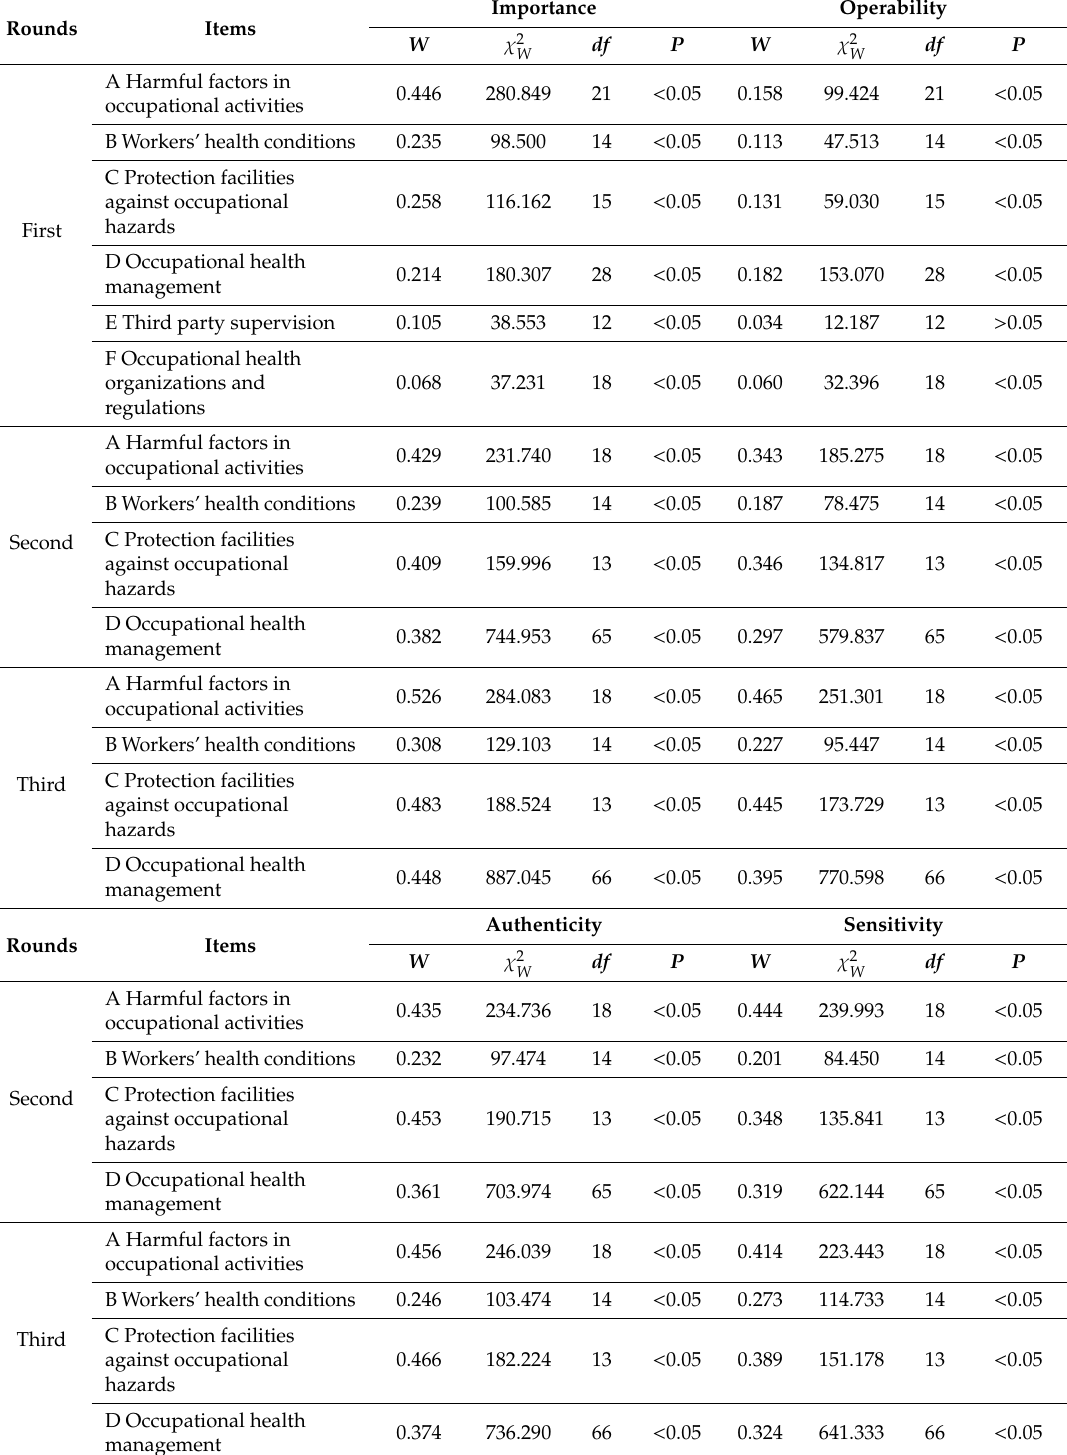
Table 3. Results of consistency and test for expert